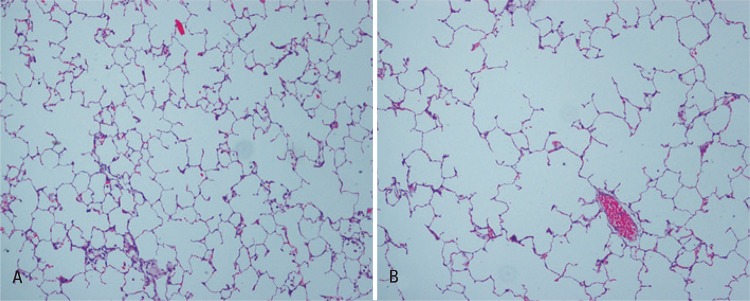
Fotomicrografias do parênquima pulmonar (hematoxilina-eosina), aumento x100. (A) Pulmão naive e (B) pulmão enfisematoso, demonstrando hiperdistensão dos ductos alveolares com ruptura dos septos alveolares